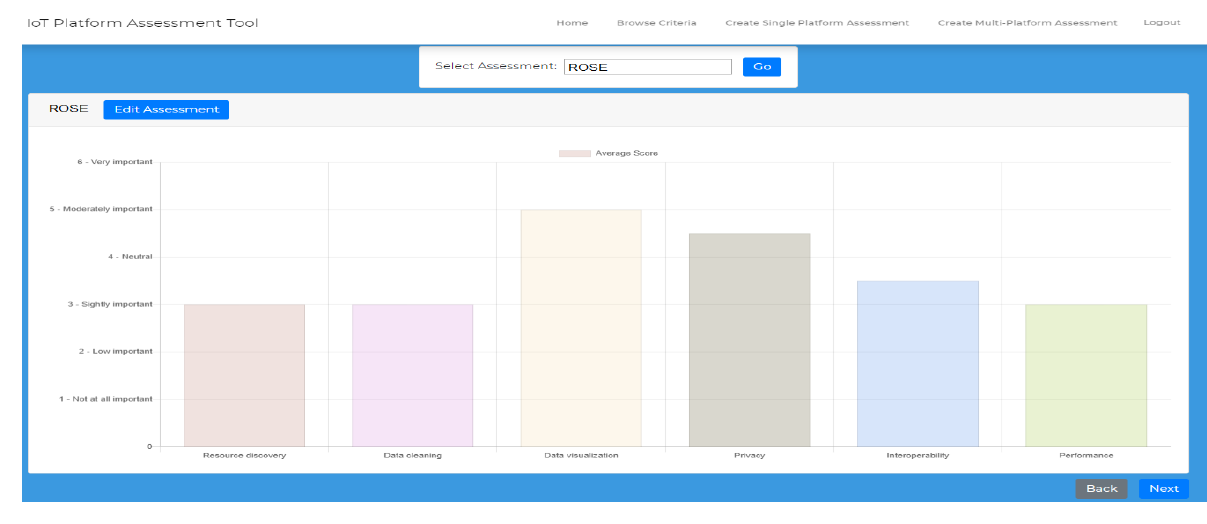
Figure 5. Assessment of the ROSE architecture via the IoT-PA (the rates are exemplar due to confidentiality).